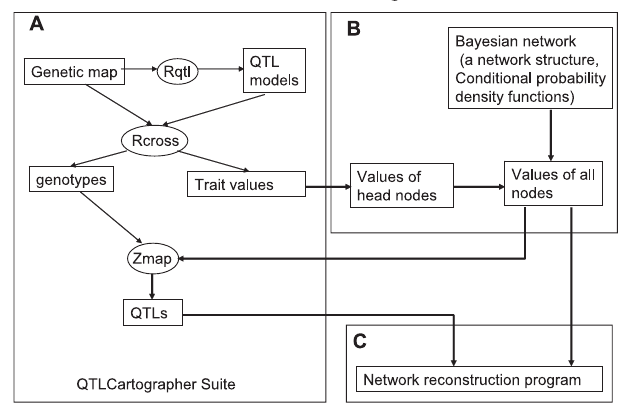
Figure 1. The Data Simulation Scheme with Genetic and Network Constraints (A) A segregating population (an F2 intercross in this case) is simulated using the QTL Cartographer software suite (Rqtl, Rcross, and Zmapqtl). The QTL model for a trait is defined using the Rqtl program, and the heritability of the QTL is defined using the Rcross program. (B) The traits simulated by Rcross are used as the head nodes in the simulated network. The remaining traits are simulated based on the values of the head nodes according to the DAG structure and the set of conditional probability density functions associated with this structure. (C) After traits for all nodes in the network are simulated, they are scanned for QTLs using the Zmapqtl program. The traits and the associated QTL are then input into the network reconstruction program.